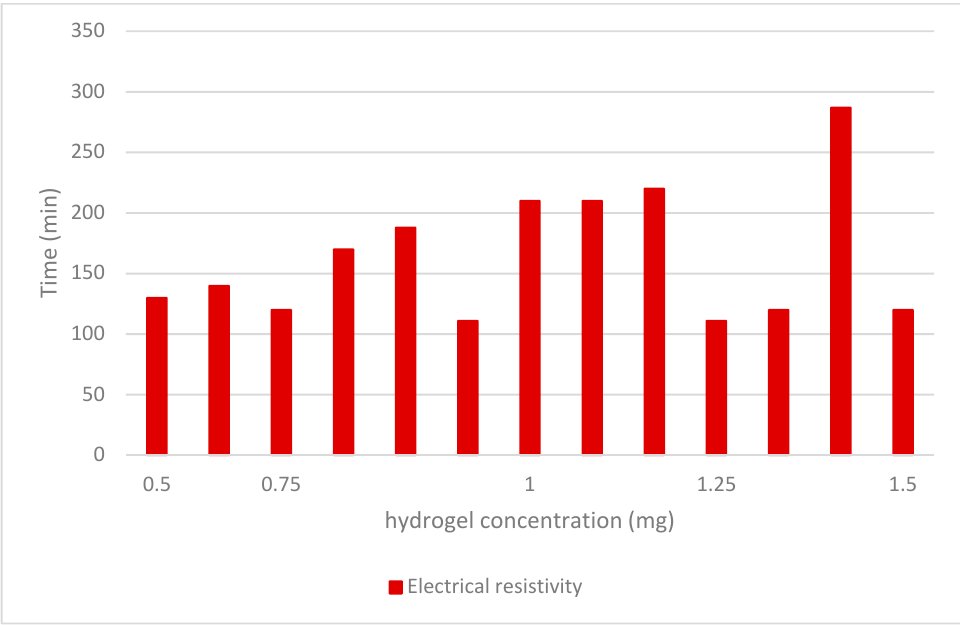
Figure 6. Compressive strength decrement in the cement-soil pastes by the raise of NSi concentration.